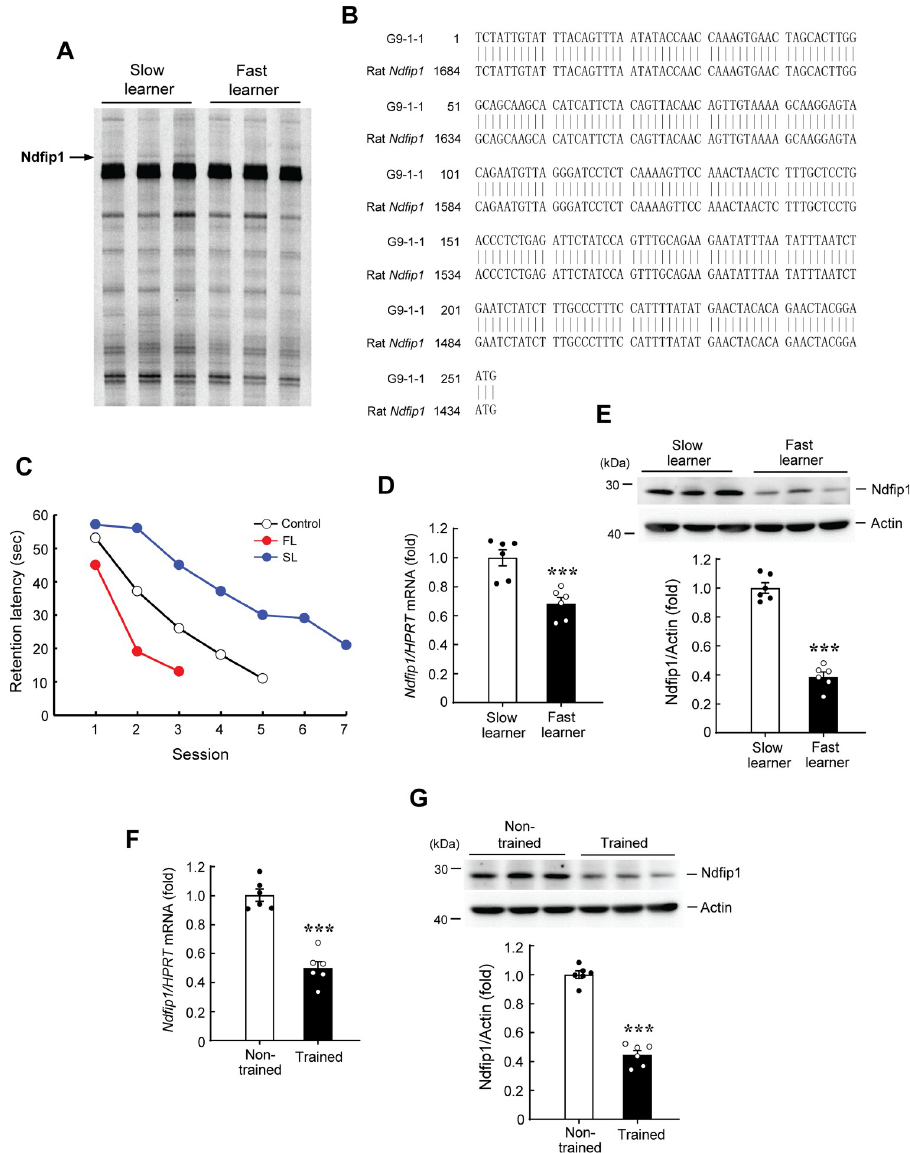
Fig 1. Identification of the Ndfip1 gene and Ndfip1 expression is decreased by spatial training. (A) DD-PCR of hippocampal RNA associated with water maze learning in rats. One cDNA fragment (indicated by the arrow) was differentially expressed between the fast learners and the slow learners. (B) Alignment of the sequence of G9-1-1 (the arbitrary primers used) with rat Ndfip1 . The numbers correspond to the Ndfip1 cDNA sequences. Vertical lines indicate identity and 100% sequence homology was found between these two. (C) Acquisition performance of fast learners (N = 6), slow learners (N = 6), and control rats (N = 22) from the water maze learning task. FL: Fast learners; SL: Slow learners. Data are expressed as mean values. (D) Ndfip1 mRNA level in the CA1 area is lower in fast learners than slow learners (t 1,10 = 4.57, p = 0.001). (E) Ndfip1 protein expression in the CA1 area is lower in fast learners than slow learners (t 1,10 = 12.43, p < 0.001). (F) Ndfip1 mRNA level in the CA1 area is lower in trained rats than the non- trained (swimming control) rats (t 1,10 = 8.15, p < 0.001). (G) Ndfip1 protein expression in the CA1 area is lower in trained rats than the non-trained rats (t 1,10 = 13.79, p < 0.001). N = 6 each group. Data are expressed as individual values and mean ± SEM. # p ≦ 0.001.